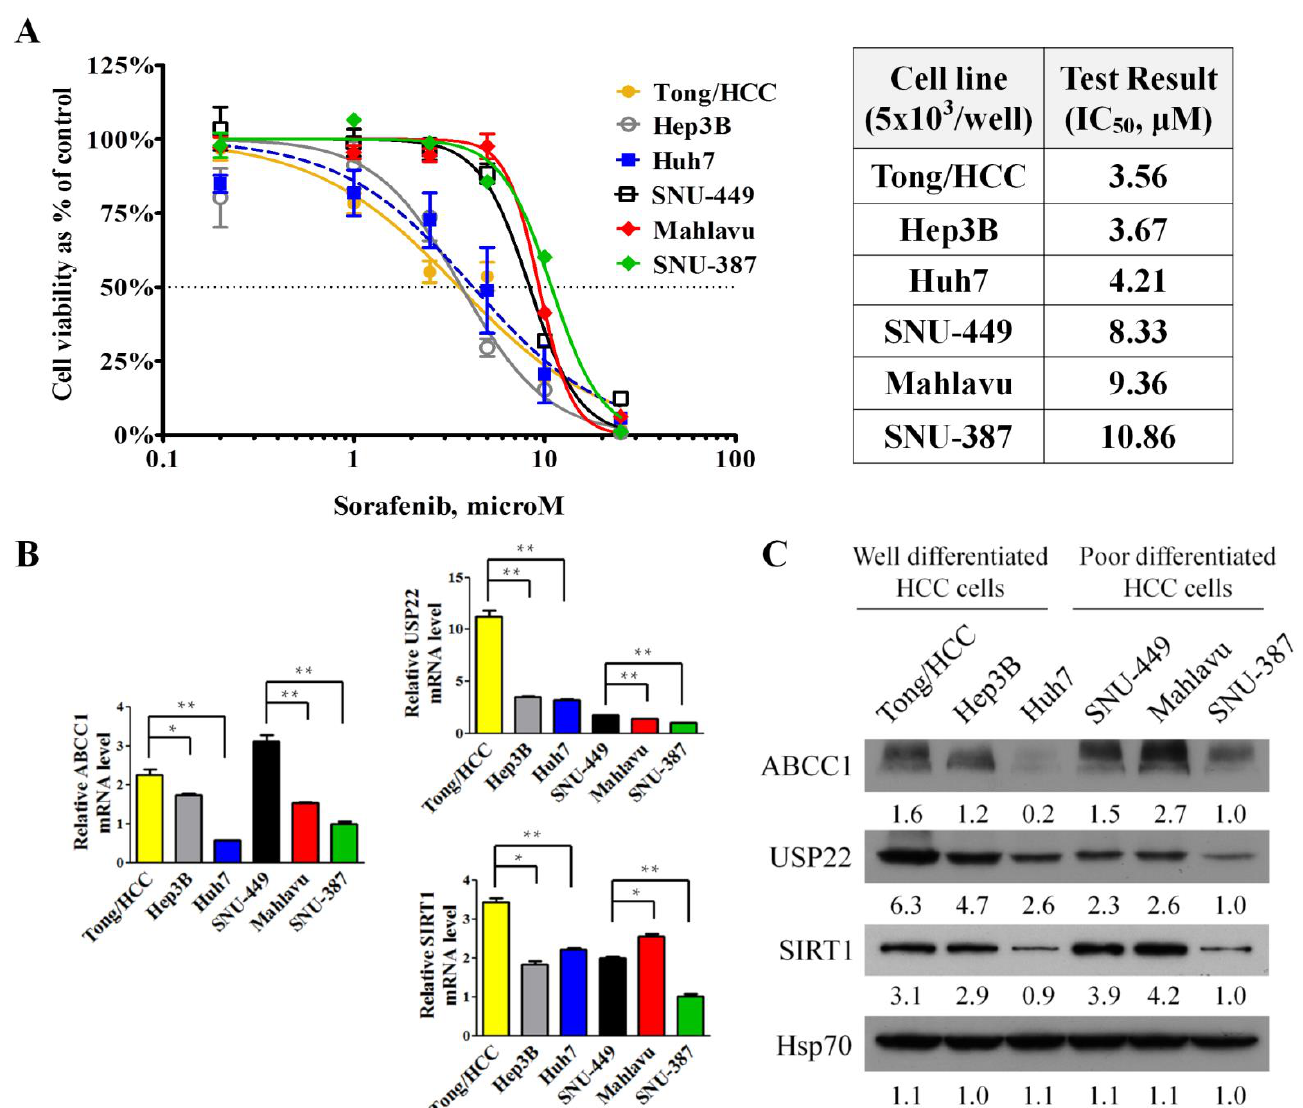
Figure 1. Growth-inhibitory effects of sorafenib in HCC cells: ( A ) Cells were treated with various concentrations of sorafenib (0.2, 1, 2.5, 5, 10, 25 μM) for 72 h. Antiproliferative effects of sorafenib on HCC cell lines were determined by MTT assay ( left panel ) and IC 50 value of HCC cell lines to sorafenib ( right panel ). ( B , C ) Expression of ABCC1, USP22, and SIRT1 in HCC cell lines analyzed by RT-qPCR and western blotting. Numeric values listed below the bands represent the indicated protein expression by densitometry analysis relative to levels in SNU-387 cells. *: p < 0.05; **: p < 0.01 compared with indicted HCC cells.